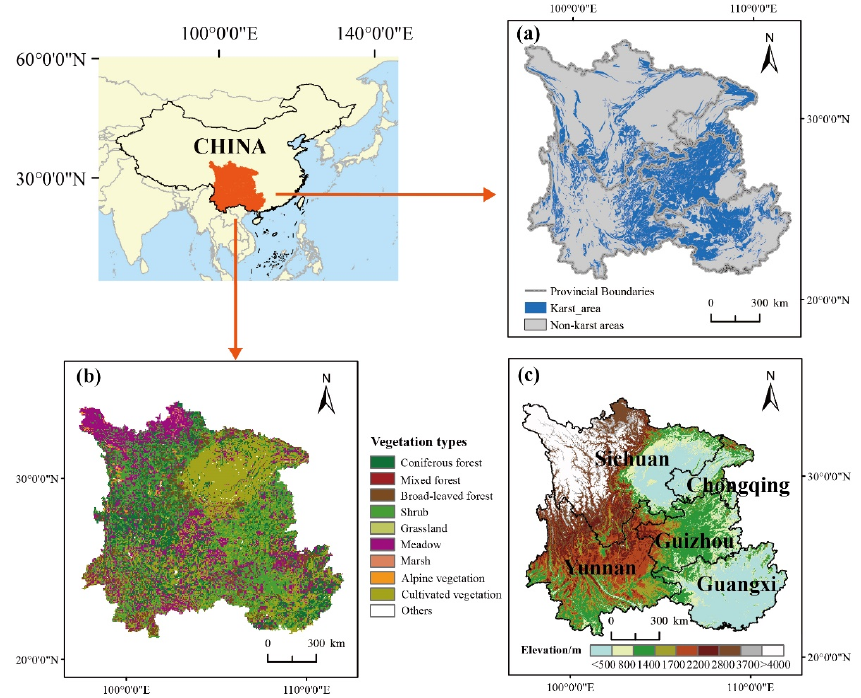
Figure 1. Location of the study area. ( a ) The spatial distribution of karst and non-karst areas; ( b ) vegetation type; ( c ) elevation.